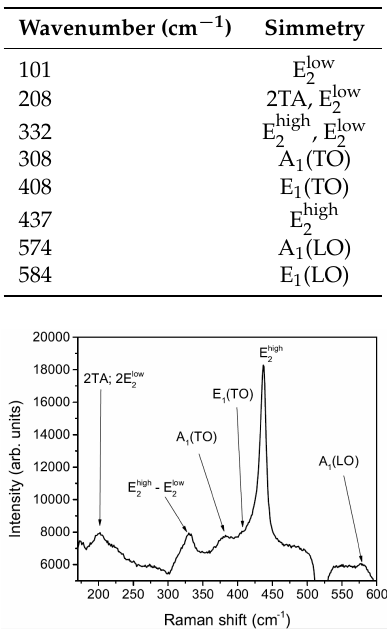
Figure 11. Raman spectrum of the thickest film deposited, to overwhelm the silicon substrate